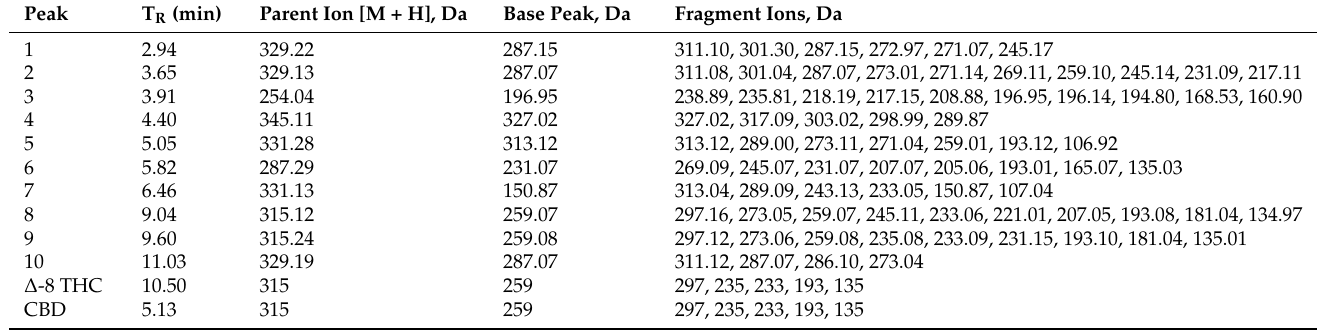
Table 2. Summary of peaks observed in MS 2 spectra.